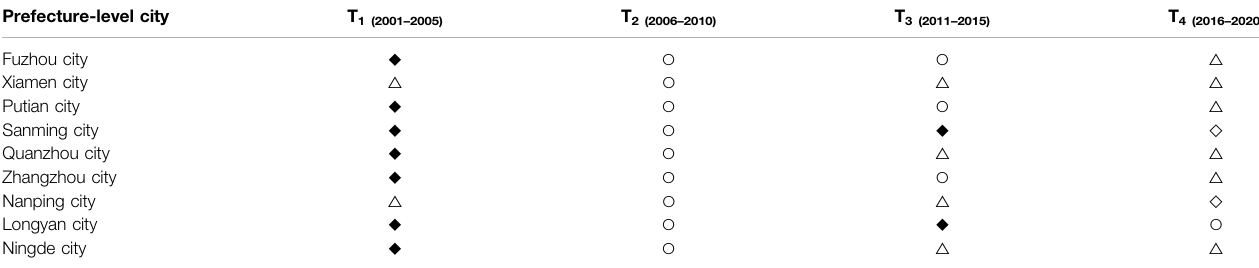
TABLE 4 | The degree of coupling and coordination between carbon emissions and economic growth in Fujian Province between 2001 and 2020. Prefecture-level